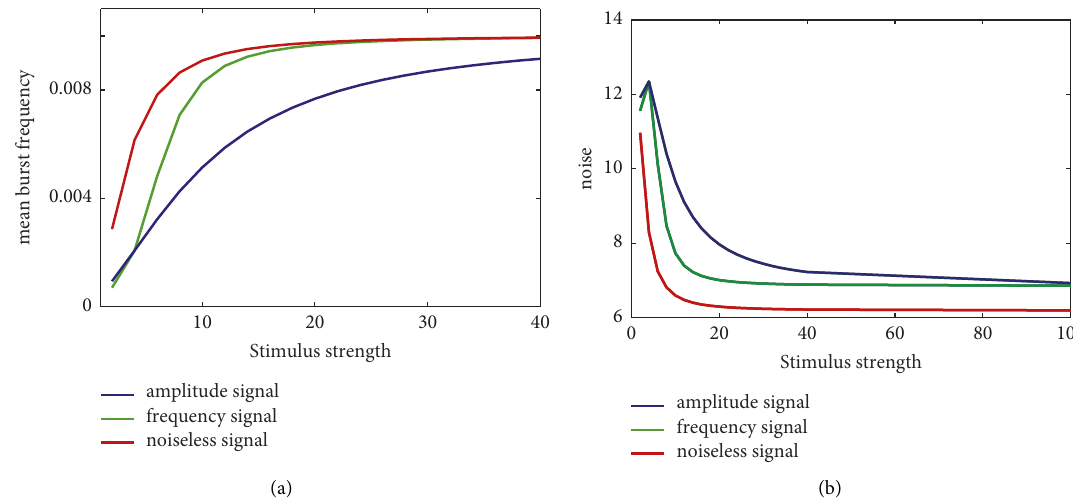
Figure 4: The mean burst frequency (a) and the noise (b) of downstream gene expression are under the FM paradigm, and the mean burst size of downstream gene expression is constant ( 〈 burst size 〉 � 500) when the strengthening extracellular stimulus increases and activates downstream gene expression. The red line represents the upstream stimulus signal as noiseless, and the green line represents the upstream stimulus signal as random with the burst frequency ( α ) changing and the burst size ( β ) being equal to 2, while the blue line represents the upstream stimulus signal as also random with the burst frequency ( α ) being equal to 2 and the burst size ( β ) changing. Other parameters are � 0 . 01, k � 0 . 1, k � 10, n � 2, λ � 1, and λ � set as k d on off 0 1